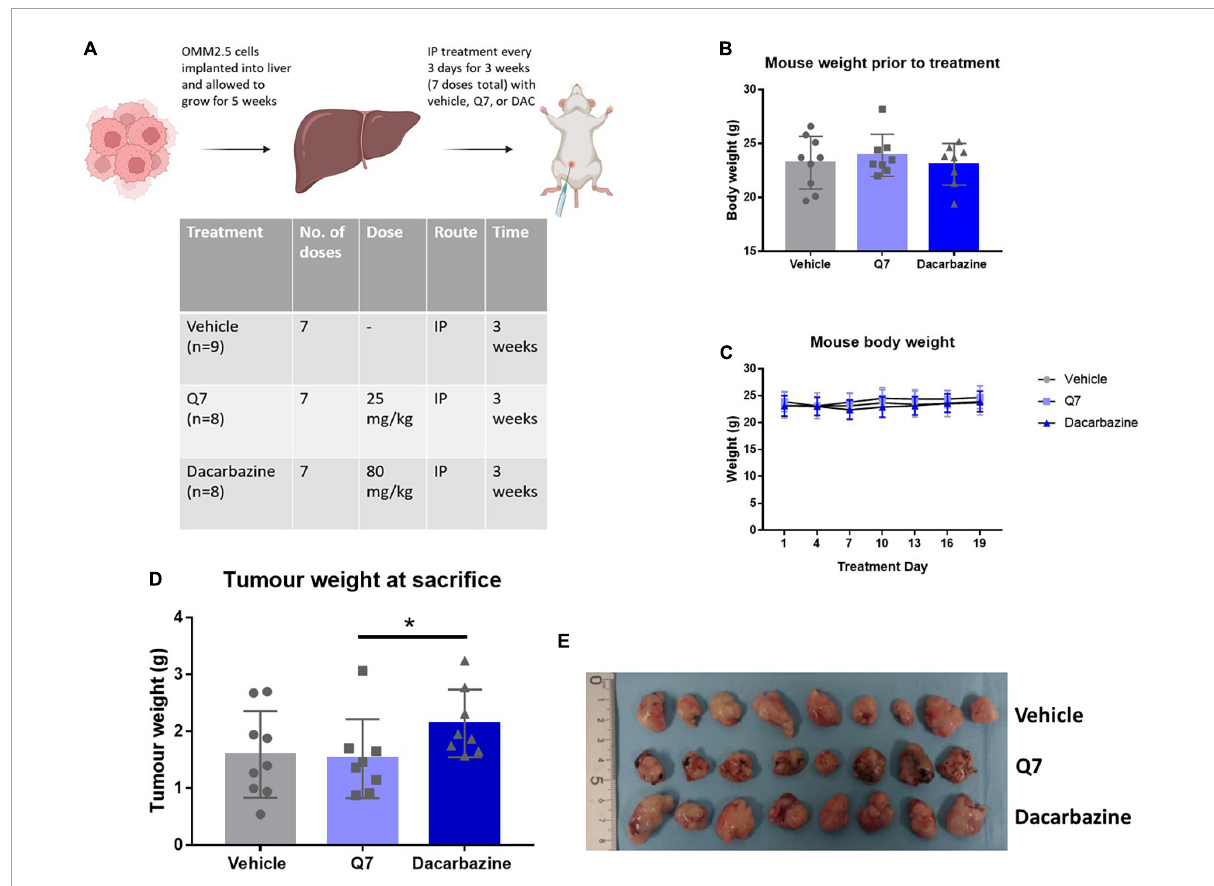
FIGURE5 Treatment with 1,4-dihydroxy quininib or dacarbazine did not significantly reduce tumour weight in an OMM2.5 cell line-derived xenograft model of metastatic UM. (A) OMM2.5 cell line-derived liver tumour fragments were implanted intrahepatically in mice and allowed grow for 5 weeks. Mice were randomized to treatment with vehicle, 1,4-dihydroxy quininib (Q7), or dacarbazine. All animals received seven doses intraperitoneally over a 3-week period. (B) Prior to study commencement, all mice with palpable tumours were randomized to vehicle ( n = 9), 1,4-dihydroxy quininib (Q7) ( n = 8), or dacarbazine ( n = 8). There were no significant differences in the weight of animals across the three different treatment groups before the study began. Body weight mean ± SD was 23.2 g ± 2.4 for vehicle, 23.9 g ± 1.9 for Q7, and 23.1 g ± 1.9 for dacarbazine. Statistical analysis was performed by a Kruskal-Wallis test. (C) Body weights were monitored every 3 days during the study period. No statistically significant differences in body weight were observed between treatment groups throughout the study. Statistical analysis was performed by a two-way repeated measures ANOVA. Error bars are mean ± SD. (E) Following necropsy, liver tumours were resected and arranged by treatment group. Individual tumours were weighed and the average weight of tumours from each group was compared. (D) Treatment with 1,4-dihydroxy quininib (Q7) or dacarbazine did not result in significant changes in tumour weight vs. vehicle control ( p = 0.81 and p = 0.14, respectively). (D) In animals treated with dacarbazine, tumour weight was significantly higher ( p = 0.023) than those treated with 1,4-dihydroxy quininib. Tumour weight mean ± SD was 1.59 g ± 0.76 for vehicle treated mice, 1.52 g ± 0.69 for 1,4-dihydroxy quininib treated mice, and 2.14 g ± 0.59 for dacarbazine treated mice. Statistical analysis was performed using a Mann-Whitney U test to compare differences between two groups. Error bars are mean ± S.D. * p < 0.05. Panel (A) created with